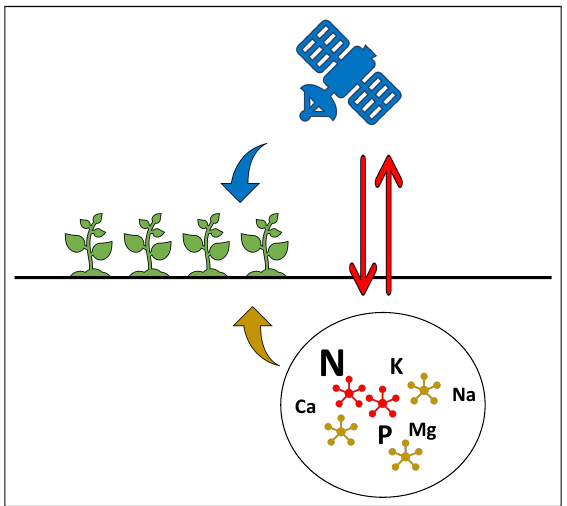
Figure 1. Graphical rendering of the multi-layered concept of the study: remote sensing sensor and soil mineral status to spatially characterize crop